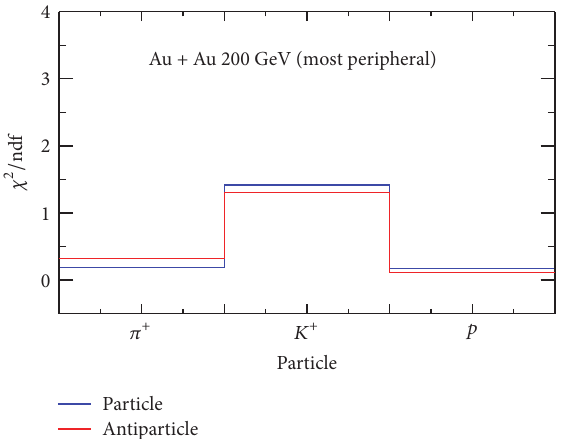
Figure 5: 𝜒 2 / ndf values are shown for most peripheral Au + Au collisions at √𝑠 NN = 200 GeV using (6) as a fit function.